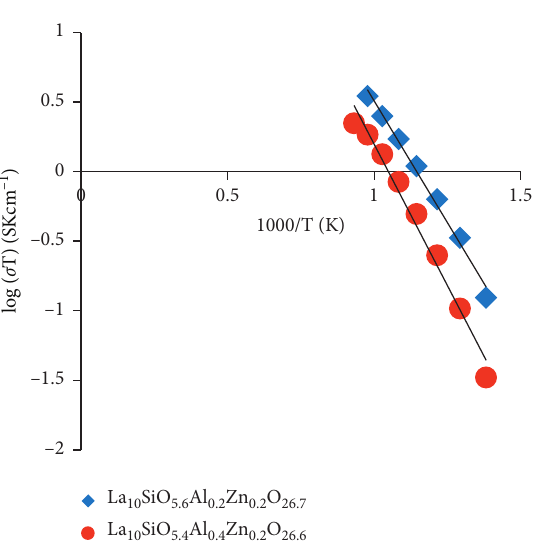
Figure 6: Arrhenius plots of total oxide ion conductivity of La